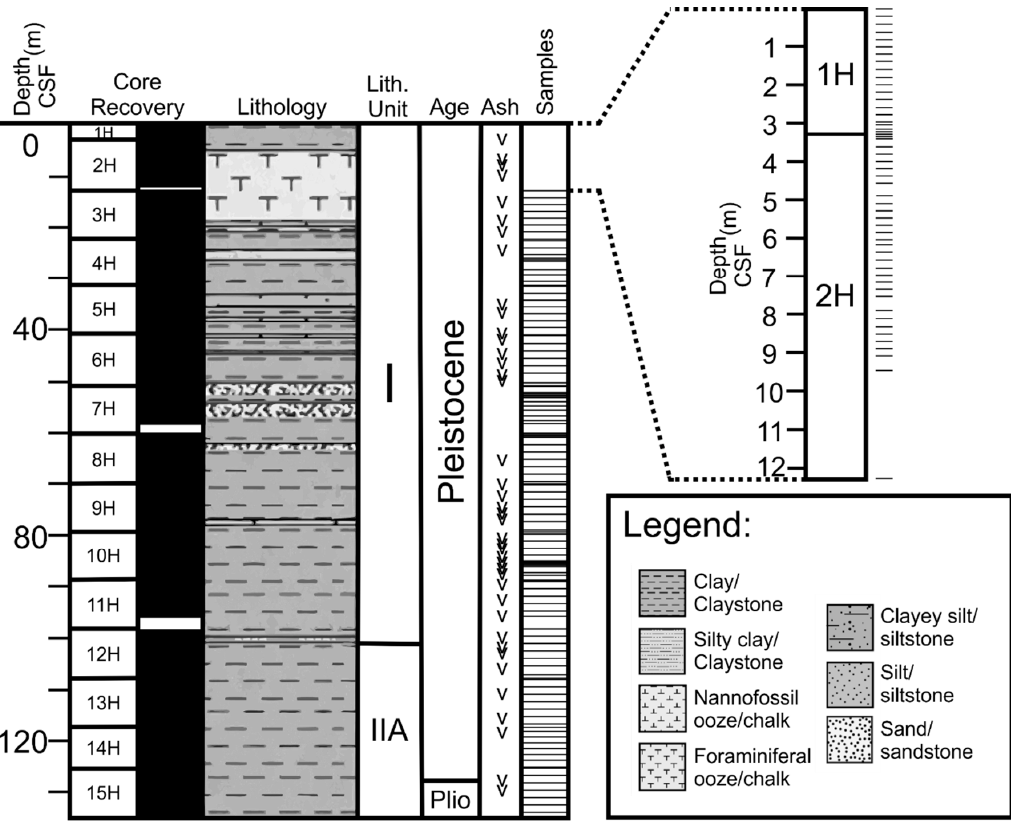
Figure 2. Schematic diagram of core sections (1H to 15H) examined in this study. It is generally composed of clays/claystone with interbeds of minor sand/sandstone, silt/siltstone, clayey silt, silty clay, and foraminiferal oozes. Age dates are determined from shipboard biostratigraphic data. White areas in the “Core Recovery” column approximates coring gaps. Horizontal lines in the “Samples” column approximate positions of the samples utilized for this study Abbreviations listed: CSF = core depth below seafloor, H = advanced piston corer, Plio = Pliocene. Figure modified from [43]. Unit II (101.16–267.82 mbsf) is divided into two sub-units. Only samples from Sub-unit IIA